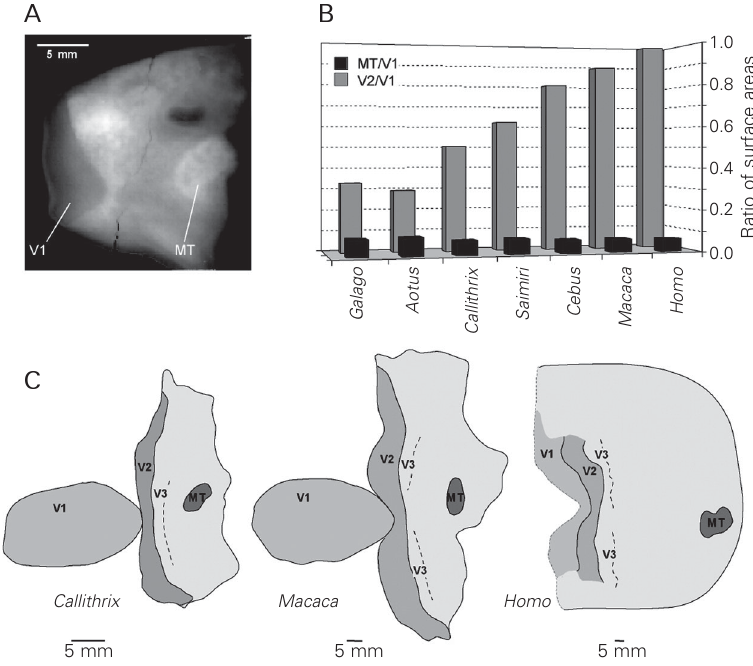
Figure 5. A , Flat-mounted vibratome slice through the brain of a marmoset. Caudal is towards the left, and dorsal towards the top. This slice has not been stained, and the borders of primary visual (V1) and middle temporal (MT) areas are made visible only by differences in myelination (highly myelinated areas appearing lighter). Although the rostral border of V2 is only faintly visible in this type of preparation, it can be easily defined in cytochrome oxidase-stained material. B , Surface areas of V2 (light grey) and MT (dark grey) as a fraction of the V1 surface, in seven species of primates. All measurements were obtained from flat-mounted sections stained for myelin or cytochrome oxidase. C , Graphi- cally “unfolded” reconstructions of the posterior neocortex of three species of diurnal primates with different brain sizes (note different scale bars at the bottom of each panel). The extents of V1, V2 and MT, as well as the location of rostral border of V3, are indicated. Left: marmoset; middle: macaque; right: human (from Ref. 53). In order to reduce the distortions introduced by the graphic unfolding, discontinuities were introduced in the maps, either along the perimeter of V1 (left, centre) or across this area (right). The human map does not indicate the full extent of V1 and V2, as only the central 15-20 (cid:1) of the visual field were mapped, using non-invasive imaging